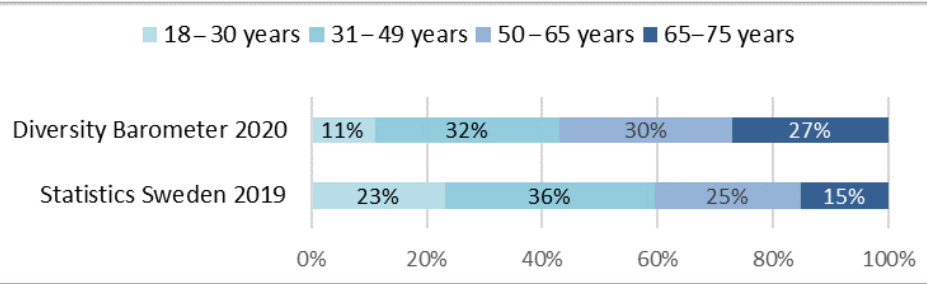
Figure 2. Age distribution: A comparison between the Diversity Barometer 2020 sample ( n = 1035) and the actual distribution of the Swedish population aged 18–75 years in 2019, also labeled as statistics Sweden 2019 in this figure (Statistics Sweden n.d.).